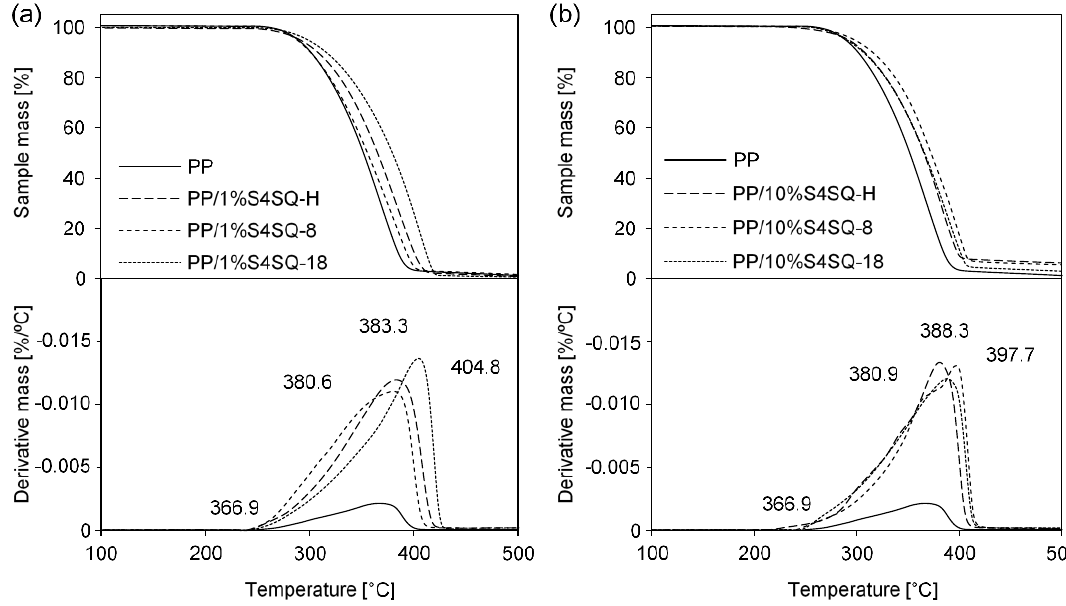
Figure 3. TG/DTG curves of neat PP as well as ( a ) PP/1%S4SQ and ( b ) PP/10%S4SQ composites (in air atmosphere).